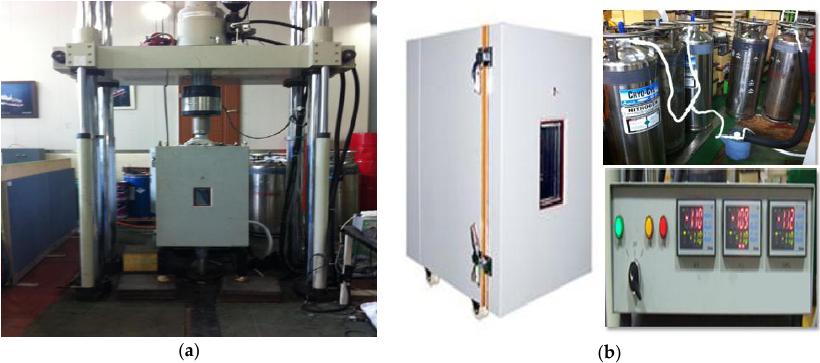
Figure 4. Compact tension specimen of crack tip opening displacement (CTOD) test.